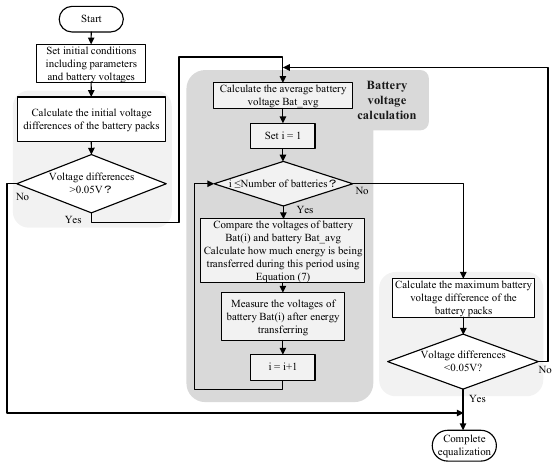
Figure 15. Flowchart of the series-parallel SC-based BE.